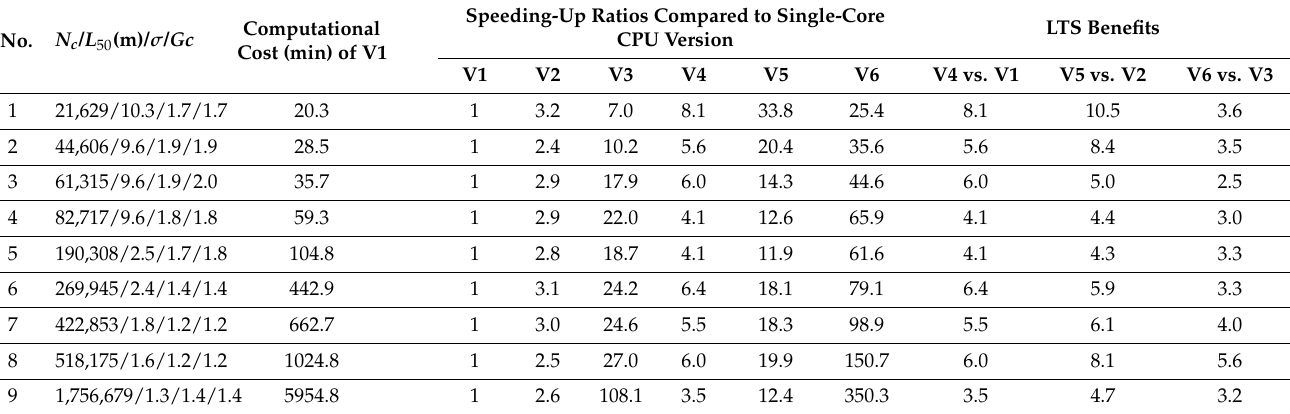
Table 4. Statistics for simulations of the field-scale scenario of tidal flows in Yangtze Estuary.